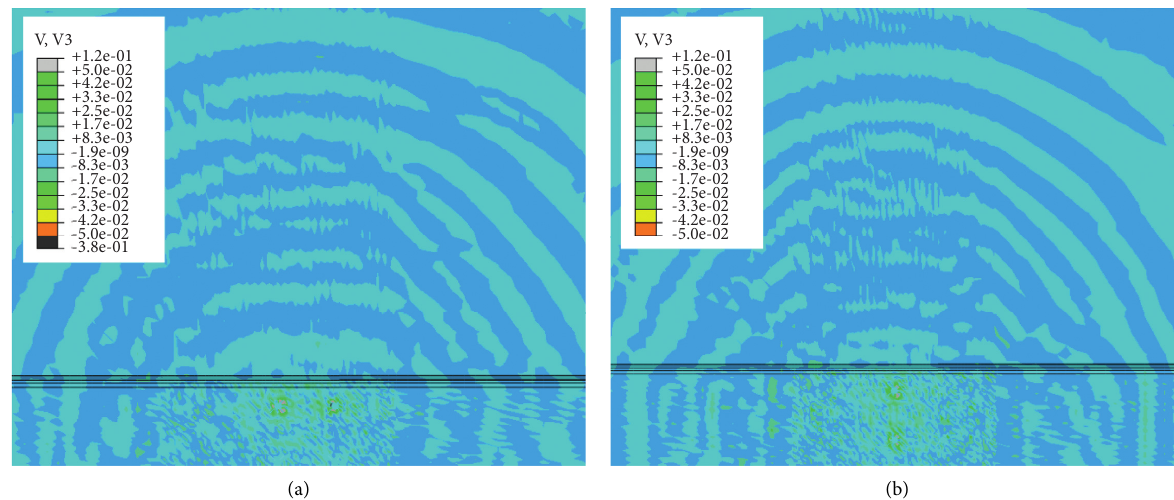
Figure 5: Nephogram of the peak vertical vibration velocity of the ground during two-hammer compaction for different compactor arrangements (m/s): (a) east-west direction and (b) north-south direction.